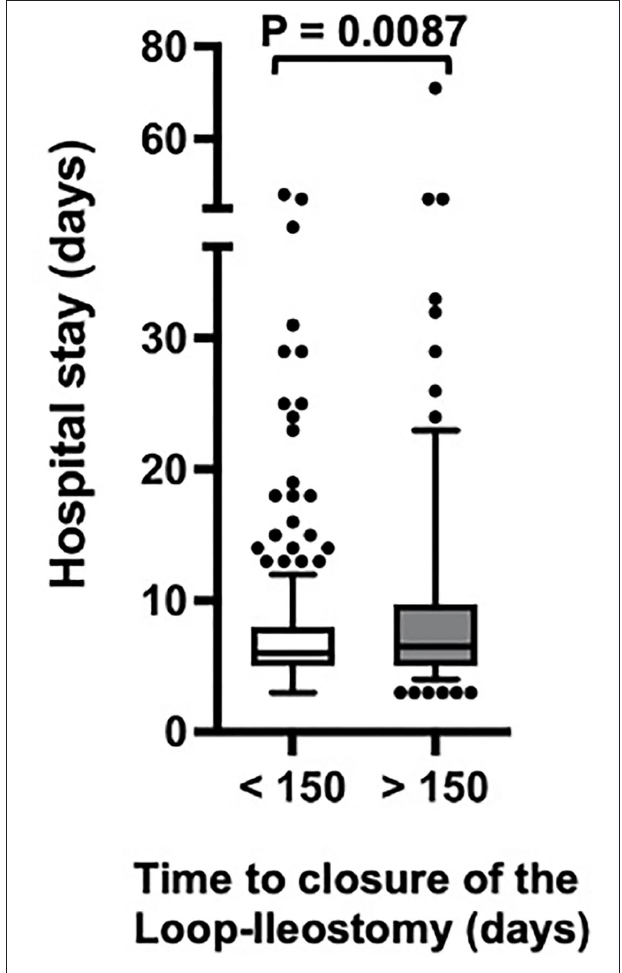
FIGURE 2 | Hospital stay depending on the time of closure of the protective loop-ileostomy. Statistic: non-parametric Mann–Whitney test.